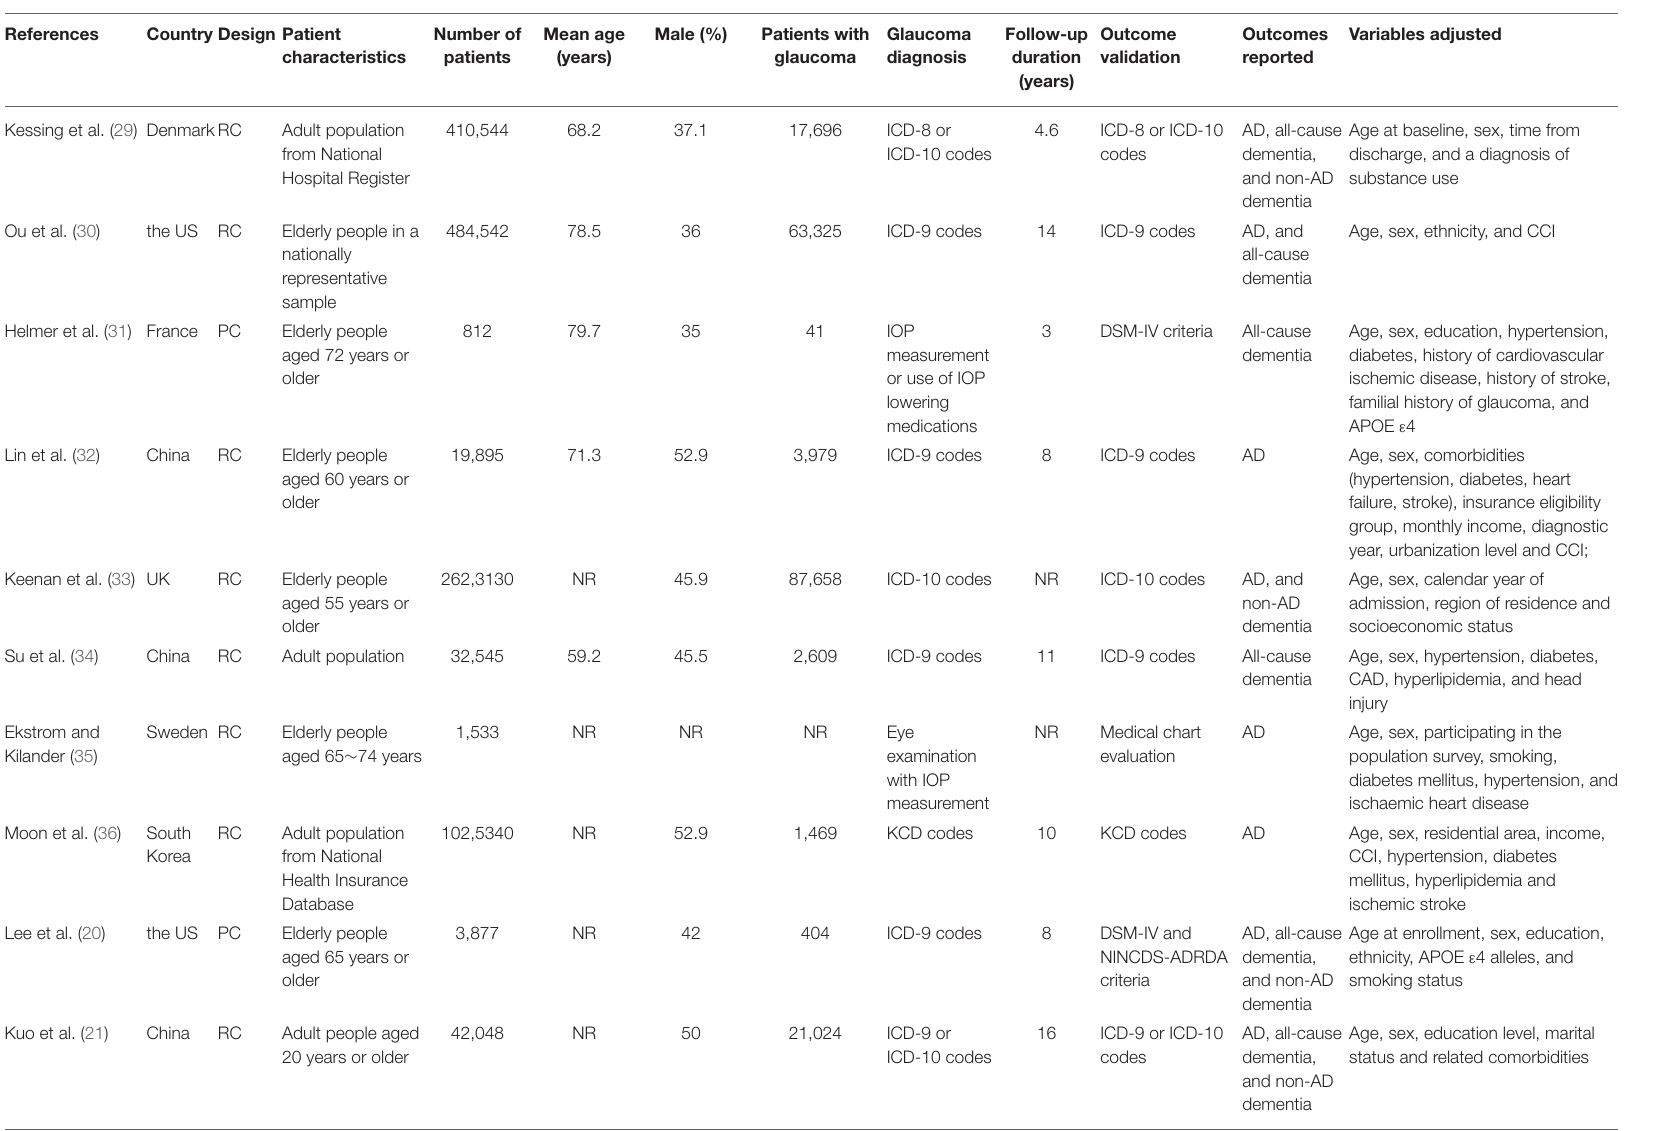
TABLE 1 | Characteristics of the included cohort